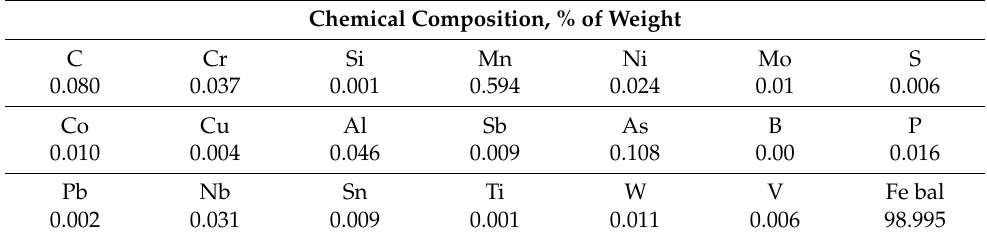
Table 1. Chemical analysis of steel scrap used in the research.